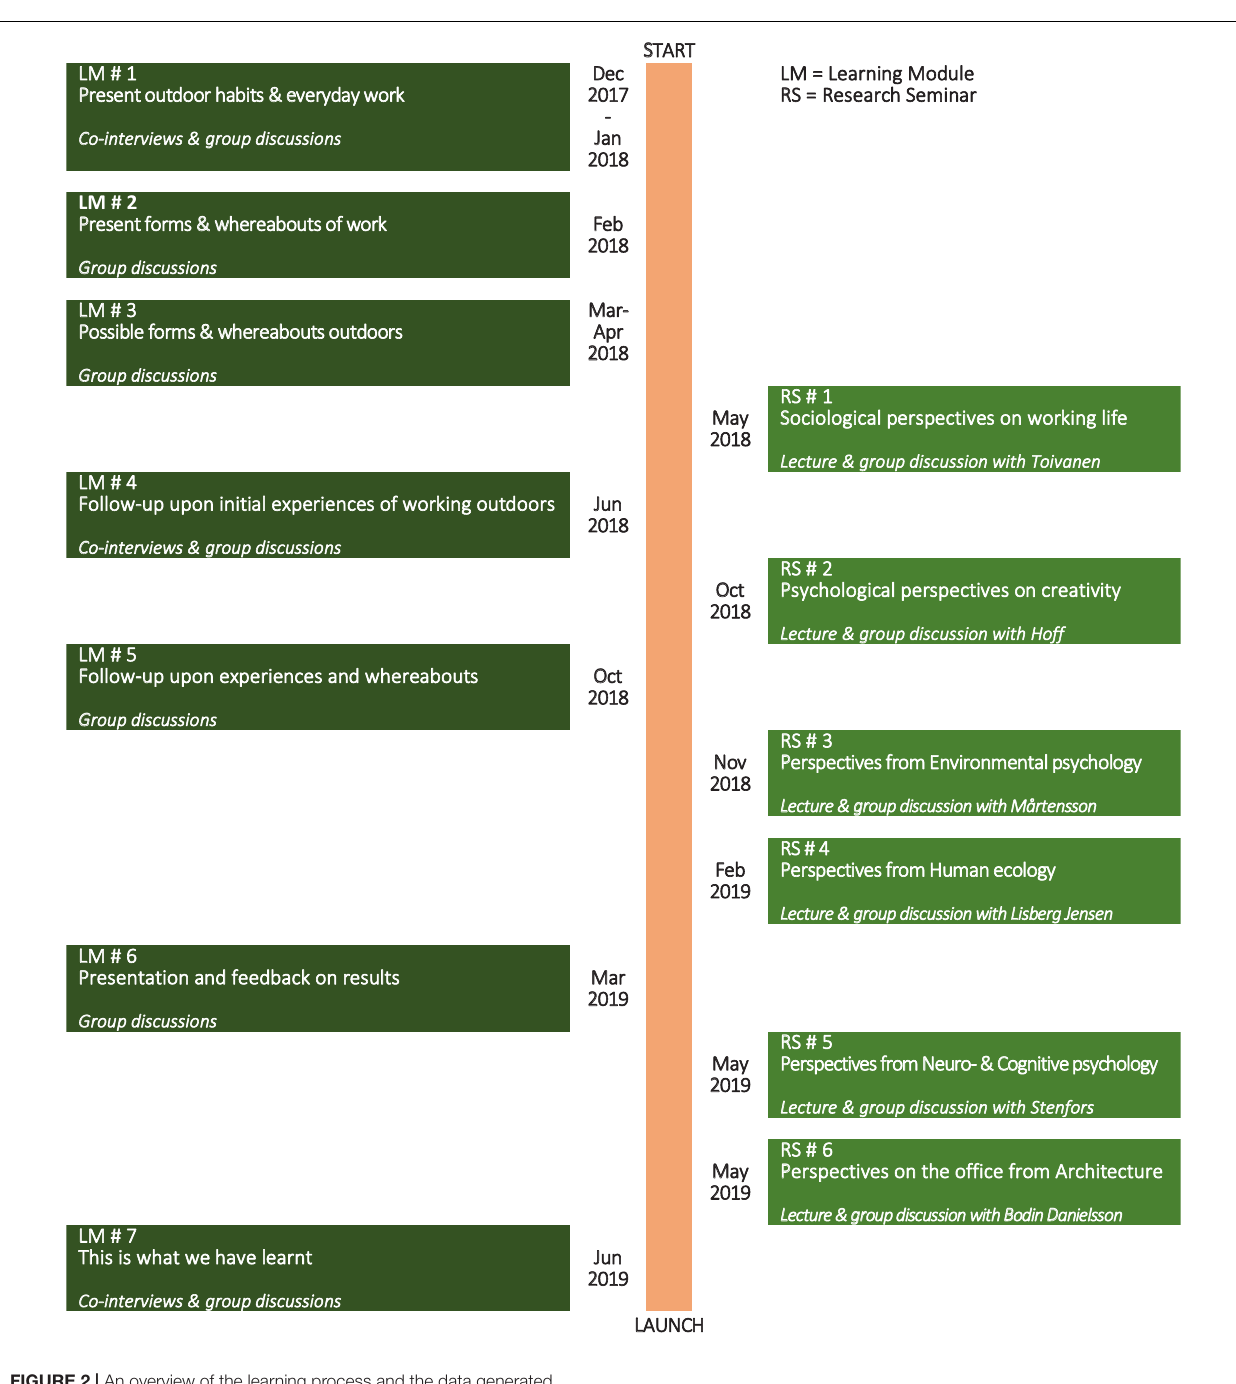
FIGURE 2 | An overview of the learning process and the data